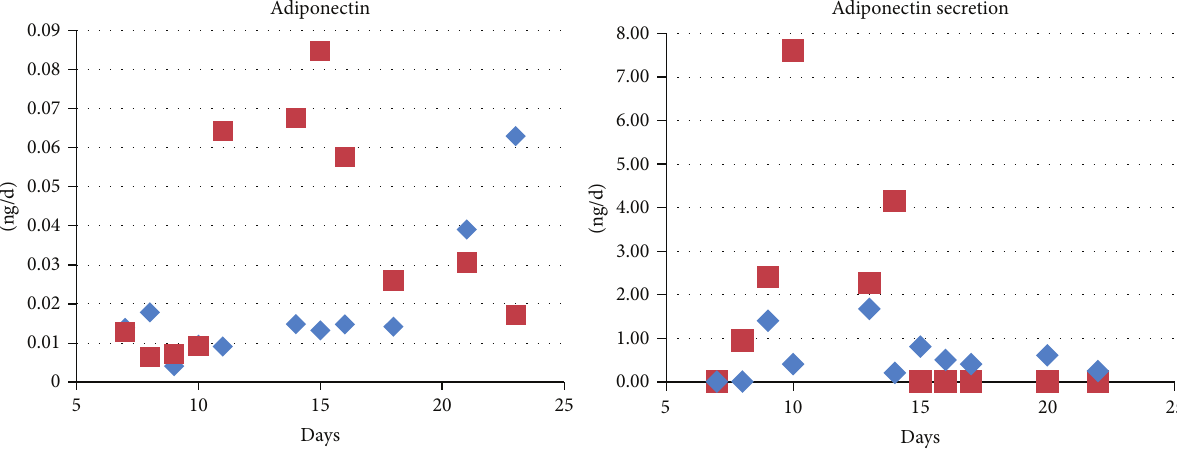
Figure 3: Adiponectin expression and secretion in response to fructose. Fructose (red squares) induces adiponectin expression transiently. The time kinetics resembles that of the lipogenic genes (Figure 1). The rise is not limited to the adiponectin transcript as cells also excrete more adiponectin during maturation when treated with fructose. Adiponectin secretion ceased once maturation was completed, irrespective of fructose in the medium. Each symbol depicts one qPCR/ELISA measurement per dish in a representative